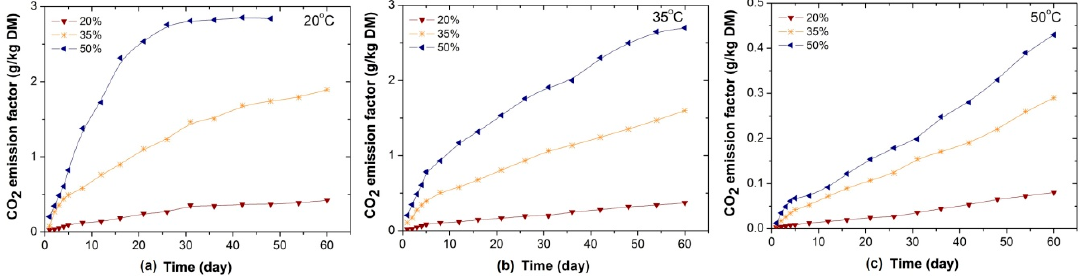
Figure 4. Emissions of CO 2 from stored WRC chips with different initial moisture contents at ( a ) 20 °C, ( b ) 35 °C and ( c ) 50 °C under non-aerobic condition.